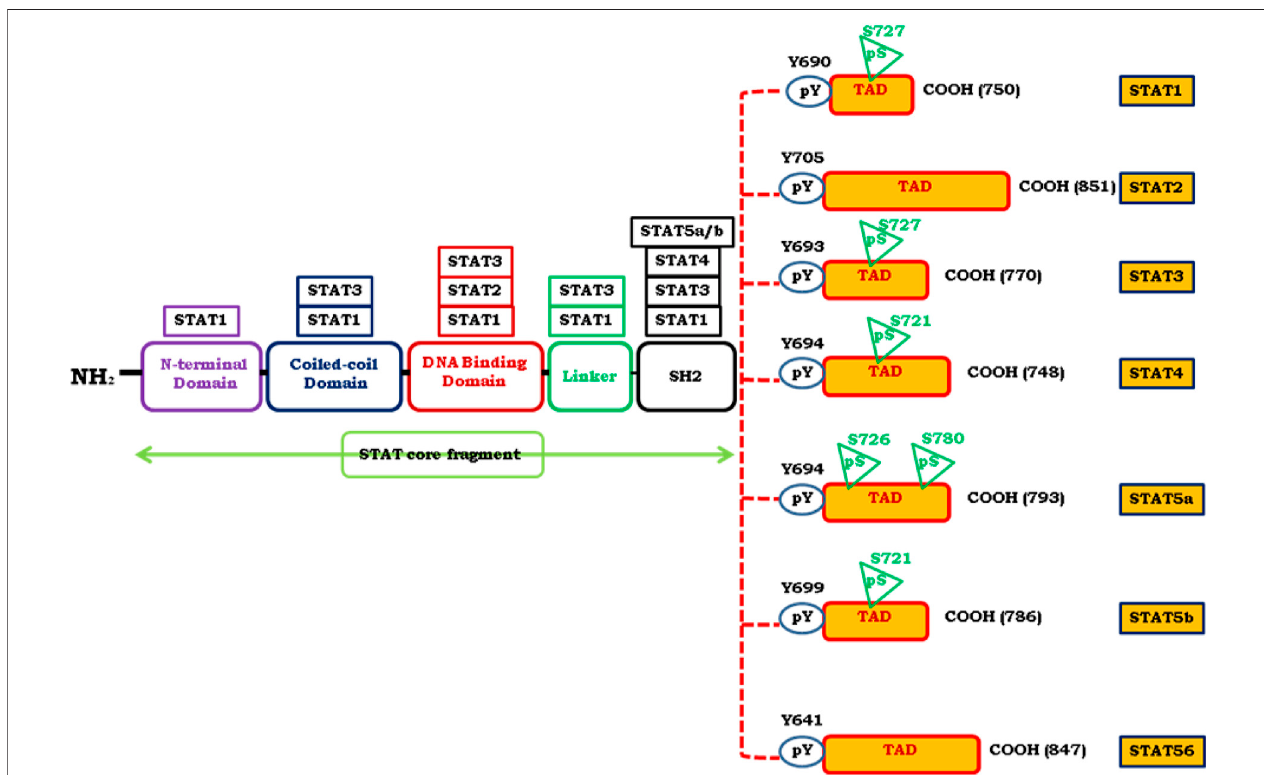
FIGURE 1 | Represents the structural and functional composition of various conserved regions of STAT proteins. STAT proteins composed of N-terminal domain, coiled-coil domain, DNA binding domain, a linker domain, Src-homology 2 (SH2) domain and a C-terminal transcriptional activation domain (TAD). TAD possesses tyrosine phosphorylation (pY) and serine phosphorylation (pS) sites which are essential for STAT activation. Location of pS and pY are depicted in fi gure. The length of amino acid chain de fi ned by the carboxylic acid (COOH) group is indicated on the right side of each STAT member.